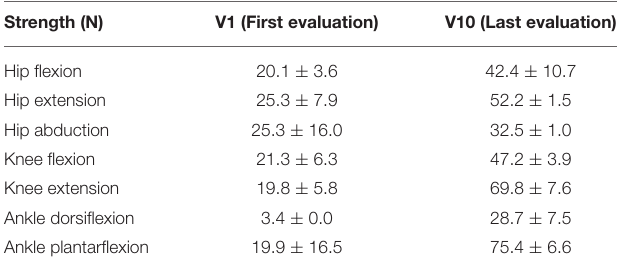
TABLE 5 | Average strength muscle in different visits. Measured with Hand Held Dynamometer (N). Strength (N)